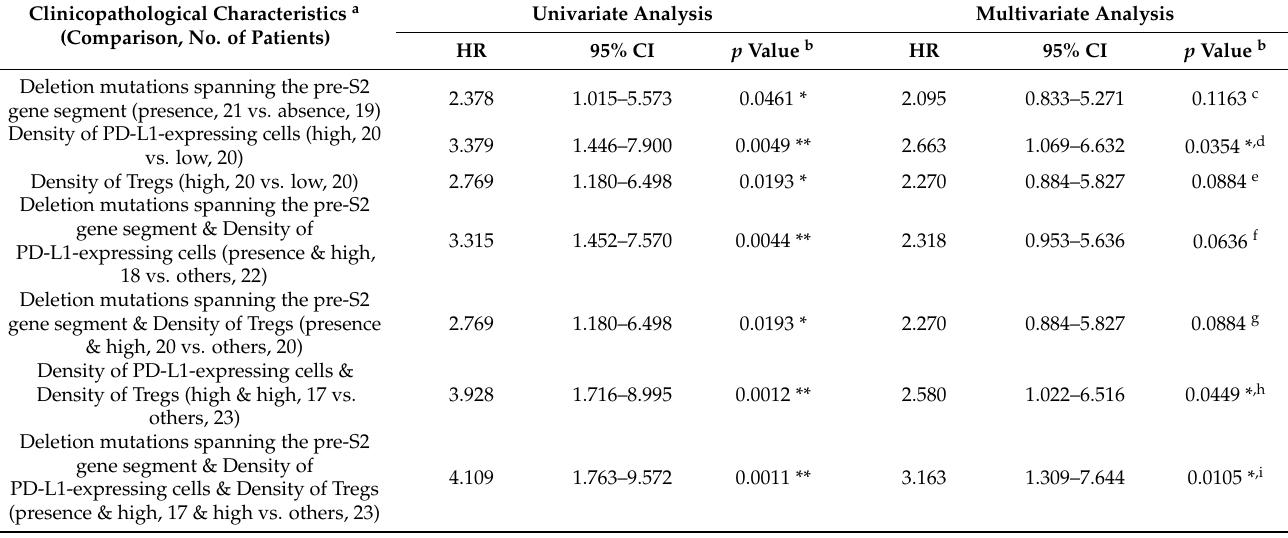
Table 3. Univariate and multivariate recurrence-free survival analyses of the 40 HBV-related HCC